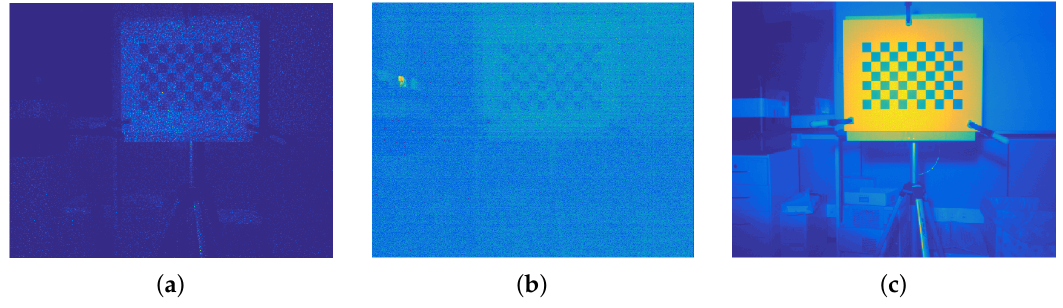
Figure 7. Infrared (IR) images of the chessboard. ( a ) Infrared image of the pattern; ( b ) Infrared image of the pattern without IR emitter; ( c ) Infrared image of the pattern without IR emitter and using a light